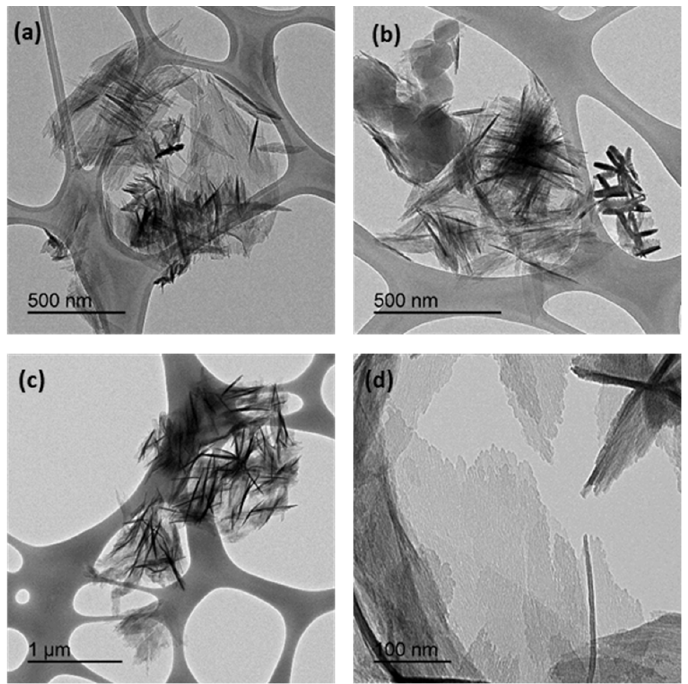
Figure 7. TEM micrographs of the synthesized materials: ( a ) CIM-80_8.5; ( b ) CIM-80_10; ( c ) CIM- 80_10_CTAB; ( d ) AlO(OH).